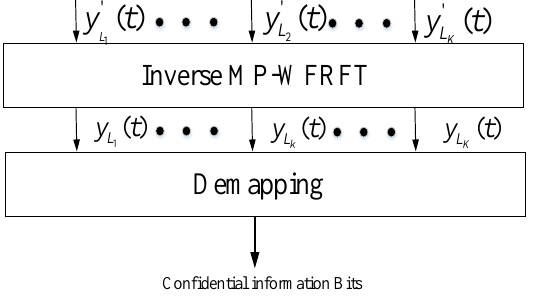
Figure 4. The receiving structure with cooperative legitimate users